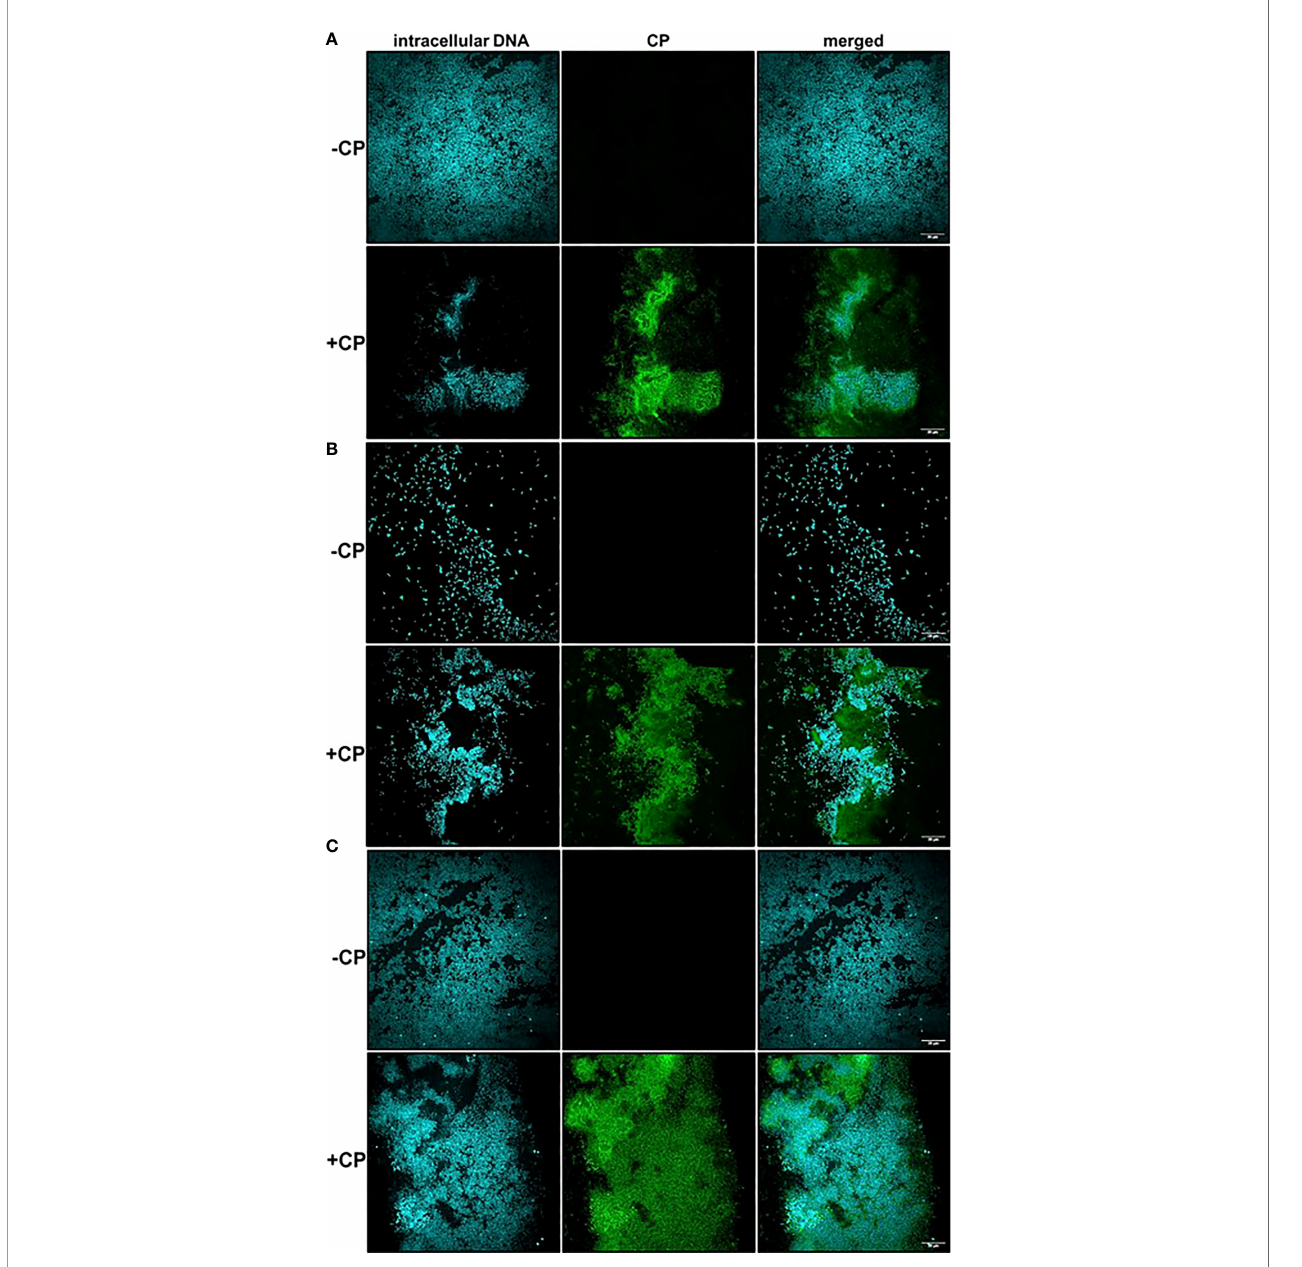
FIGURE 2 | Calprotectin is a major component of the mesh-like structure that encapsulates P. aeruginosa and S. aureus bio fi lms. Intracellular DNA of microbial cells was detected by staining with the cell-permeant nucleic acid dye, Hoechst 33342; CP was detected by staining with Alexa fl uor 488-tagged Goat anti-Rabbit antibody. (A) P. aeruginosa monoculture (B) S. aureus monoculture (C) P. aeruginosa - S. aureus co-culture. Images show 100X magni fi cation and were processed using